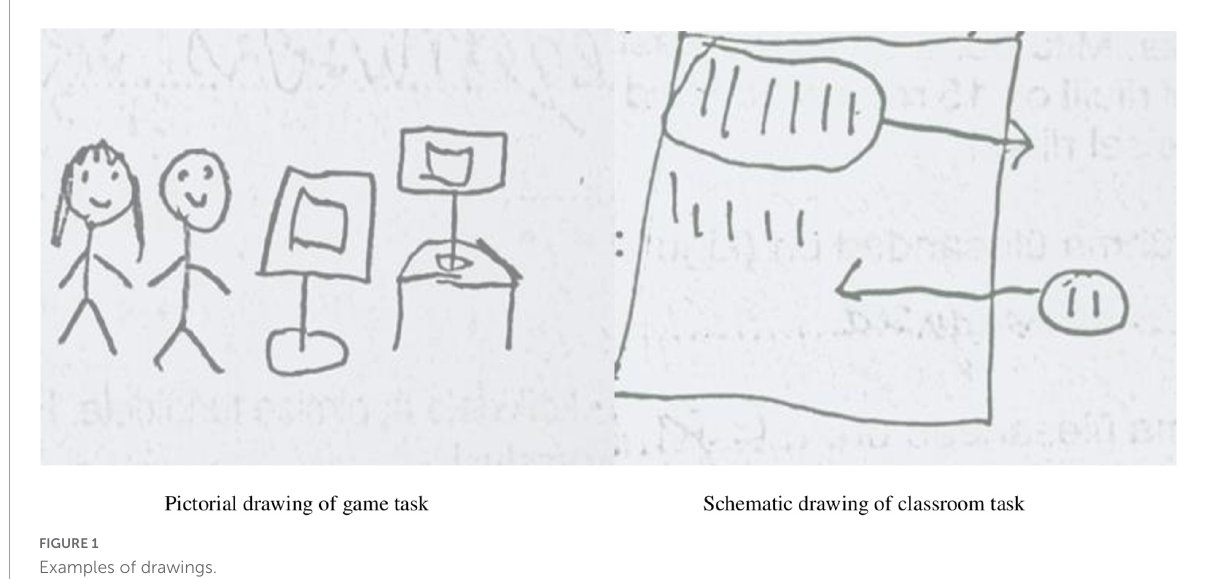
FIGURE1 Examples of